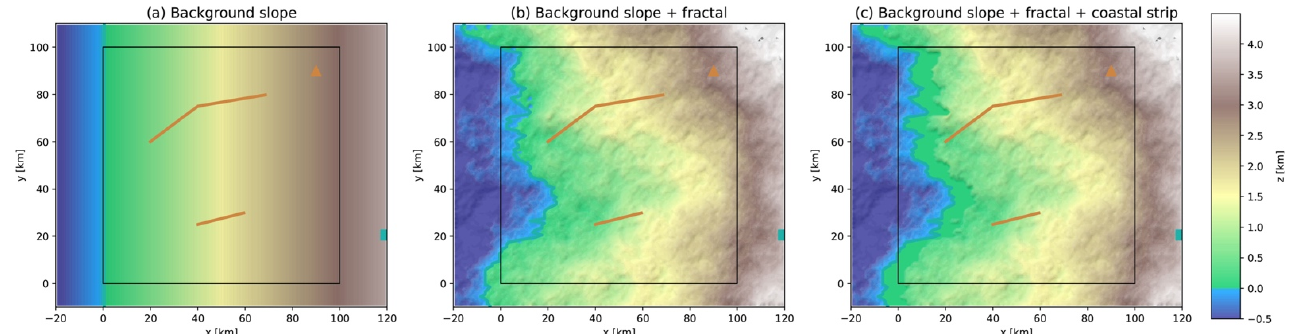
Figure 3. Creation of the background topography for the parameter values given in Table A3. ( a ) Background slope for water evacuation on the western side (step 1); ( b ) fractal topography addition (step 2); ( c ) coastal strip intrusion (step 3). The black box represents the active region. Fixed peril source locations are the same as in Figure 1 and follow the color coding of Table